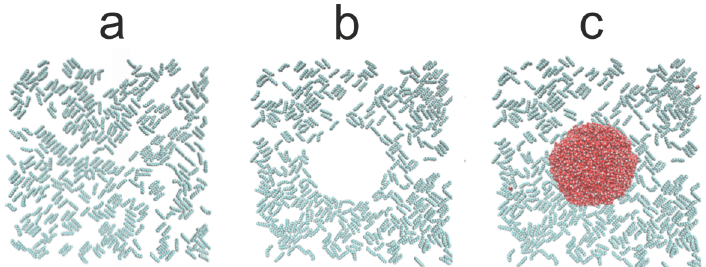
Figure 6. Simulation snapshots (top view) of water droplet on n-decane-covered silicon at C HYDR = 0.73 molecules/nm 2 . The snapshot of the alkane on silicon before the water drop was introduced ( a ), the configurations of alkane molecules after the water drop was introduced (( b ) water molecules are not shown), and the snapshots of water drop with the alkane molecules ( c ). Silicon surface is not shown for clarity.